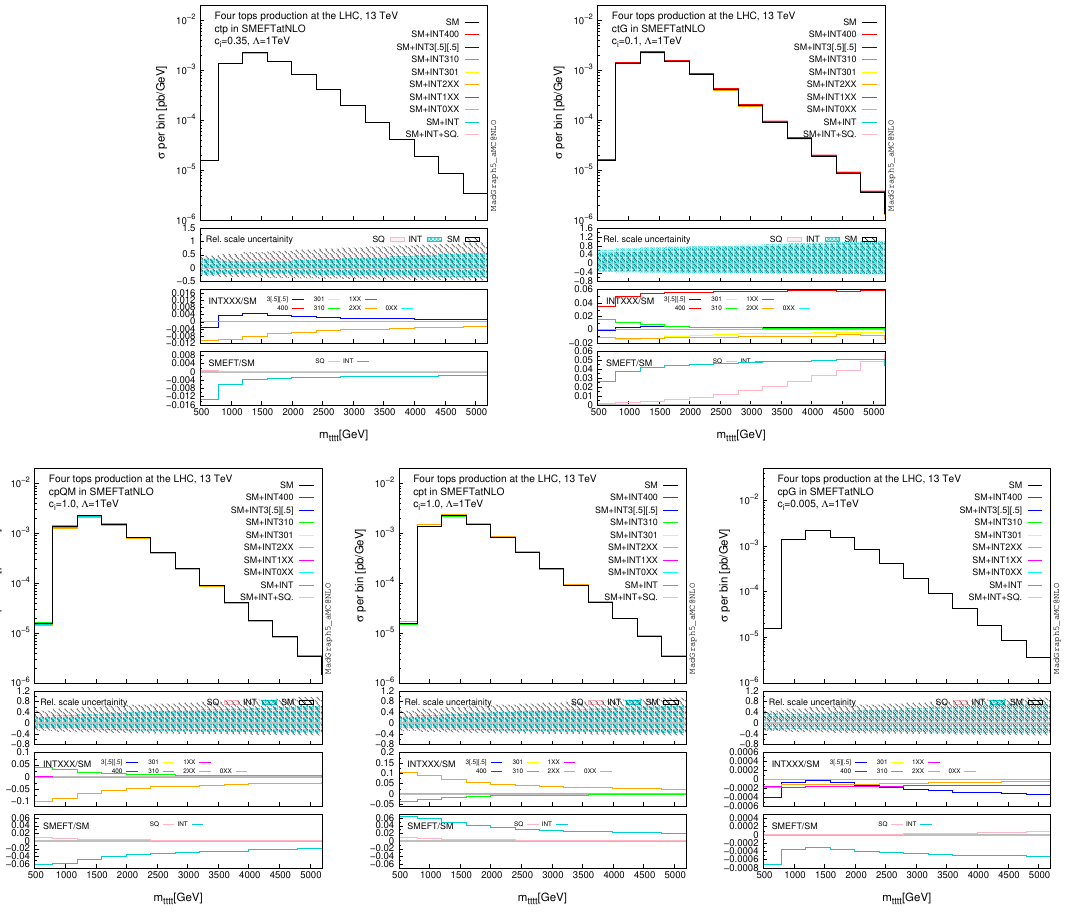
Figure 11 . Same as figure 10 but for the non-naive two-fermion and purely-bosonic operators.